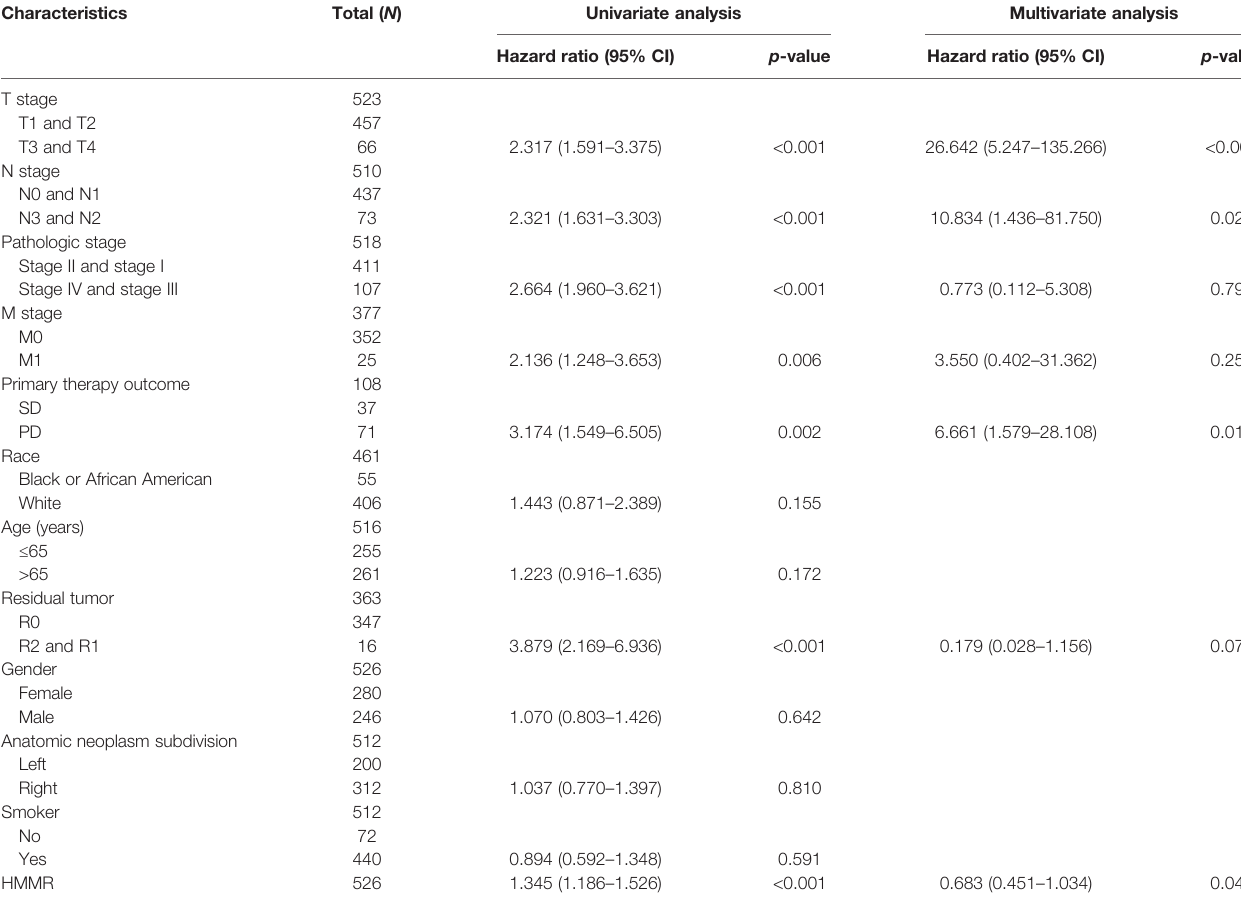
TABLE 2 | Univariate regression and multivariate survival model of the prognostic covariates in patients with lung adenocarcinoma (LUAD).